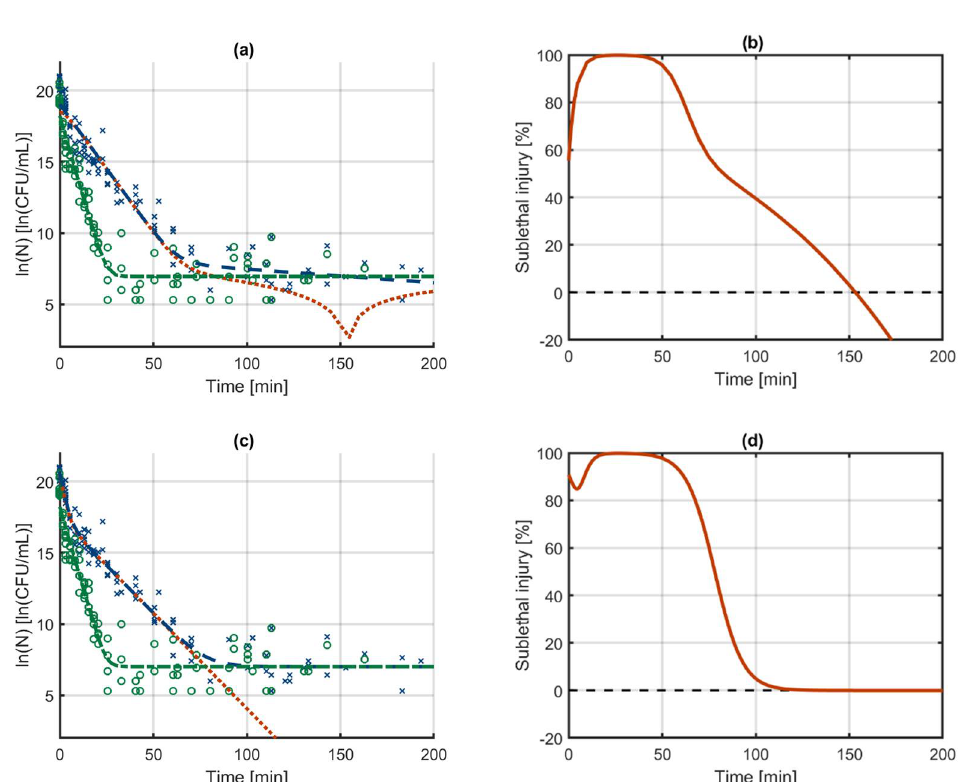
Figure 4. Biphasic inactivation of all culturable (—) and healthy culturable (- · -) cells as described by ( a ) the independent models and ( c ) the sublethal injury model that are constructed with the model of Cerf [50]. Based on these modelling results, the evolution of the sublethally injured population ( ··· ) and the percentage sublethal injury (—, ( b , d ) are calculated. The data are based on counts of culturable (x) and healthy (o) cells on non-selective and selective media as published by Noriega et al. [12]. The data were obtained by heat-treating low-density colonies of Listeria innocua at 54 ◦ C (Dataset